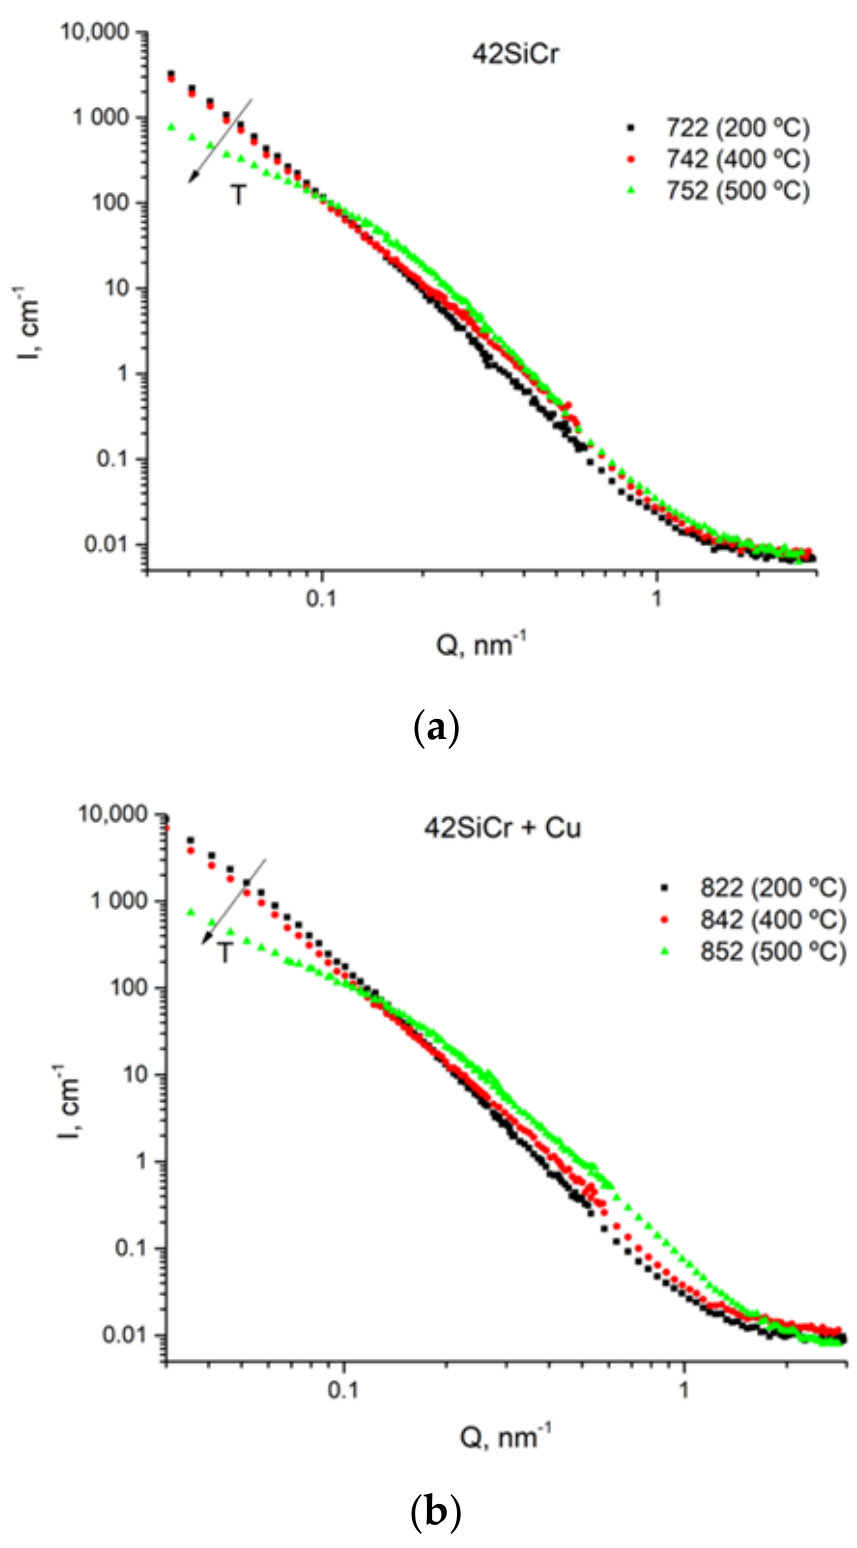
Figure 14. SANS curves for 42SiCr steel ( a ) and for 42SiCr + Cu steel ( b ).